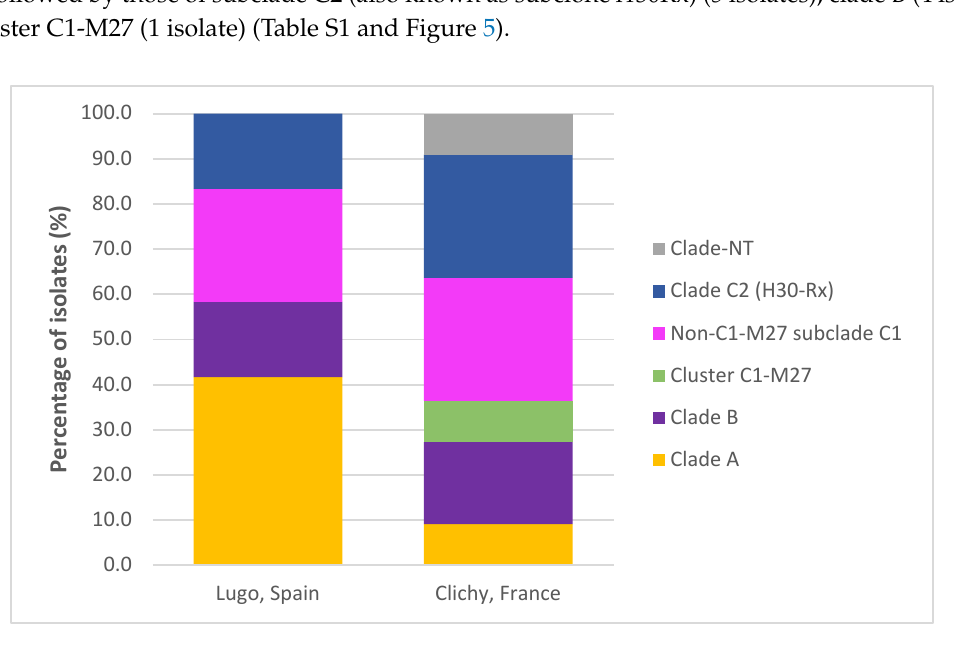
Figure 5. Comparison of the distribution of sequence type 131 (ST131) clades and clusters in the two hospitals.